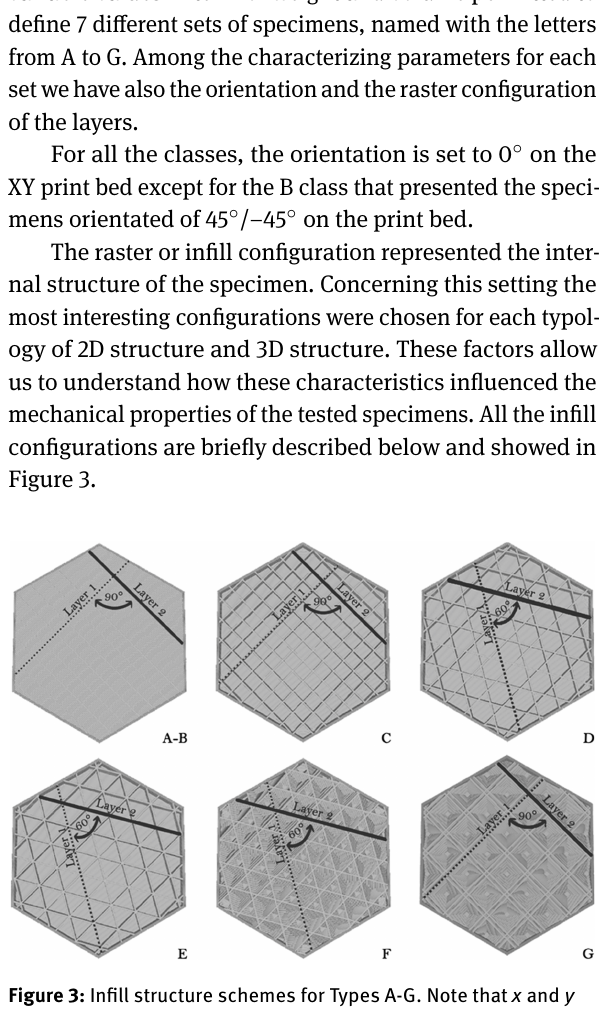
Figure 3: Infill structure schemes for Types A-G. Note that x and y reference of the printing bed correspond to horizontal and vertical directions in the figure